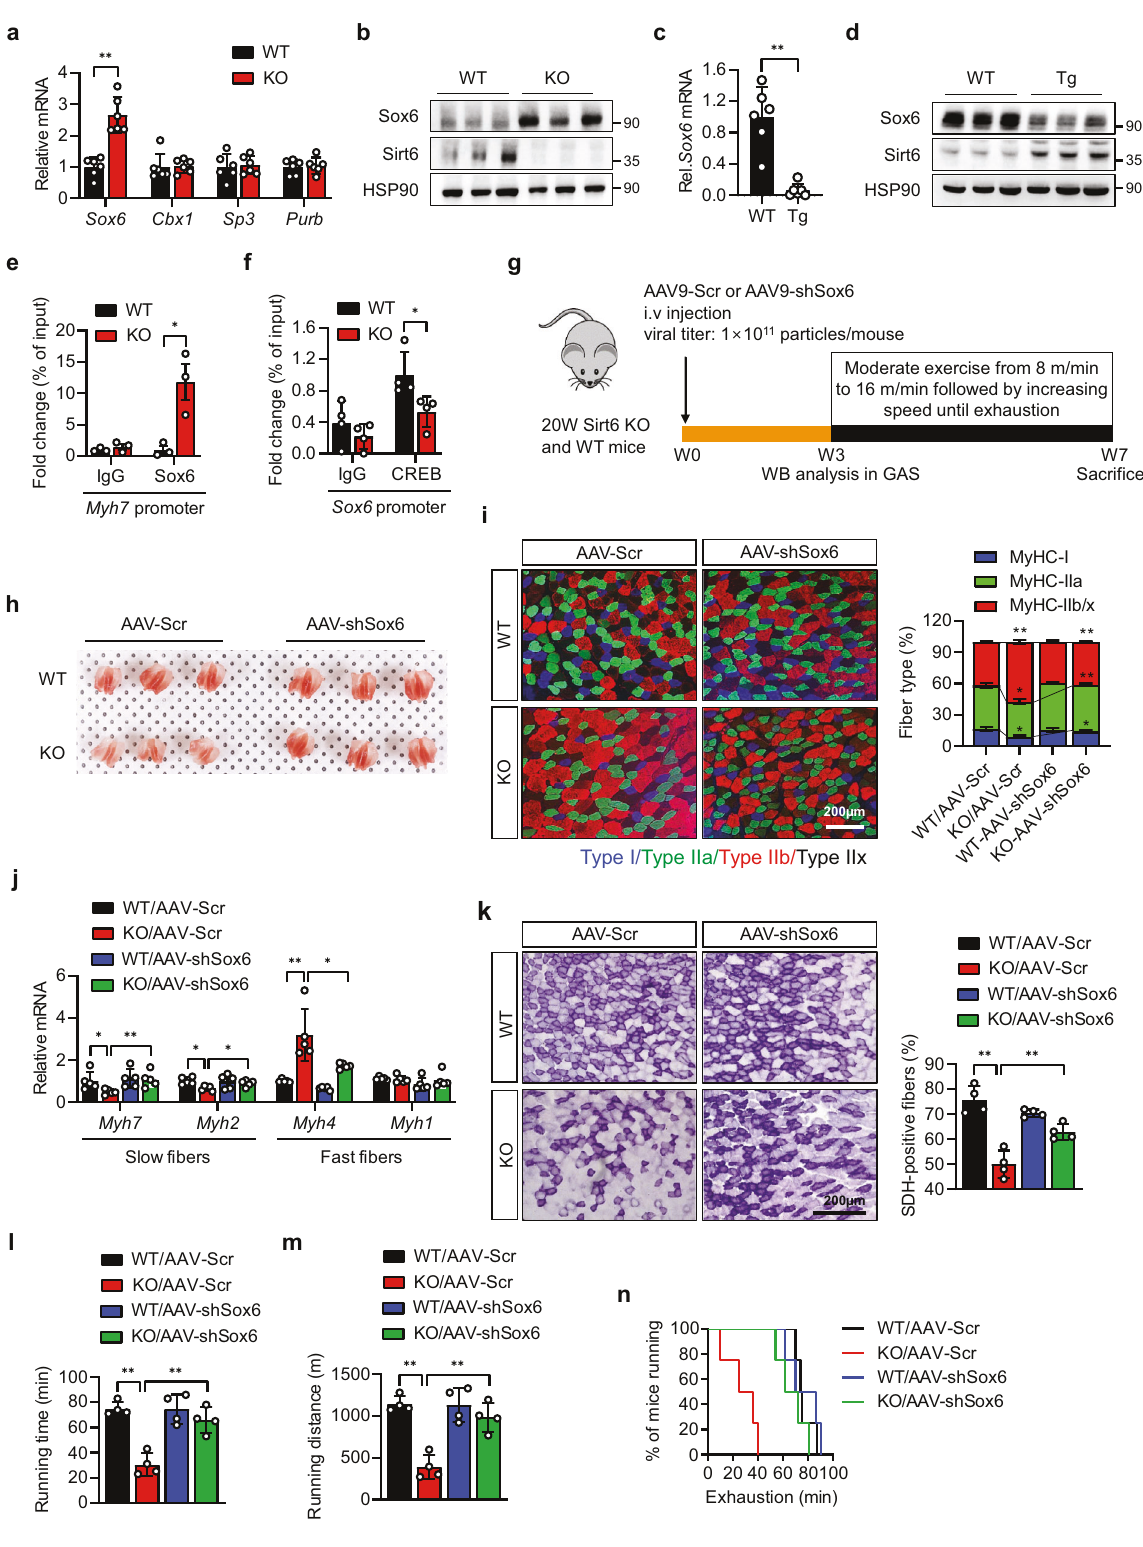
We utilized multiple animal models and in vivo gene delivery tools to manipulate Sirt6 gene expression speci fi cally in skeletal muscle. Despite the varying degree of tissue speci fi city of Sirt6 gene manipulation, the results of the gene deletion (i.e., skeletal muscle-speci fi c Sirt6 KO ( Myl1-Cre ) as well as AAV-shRNA